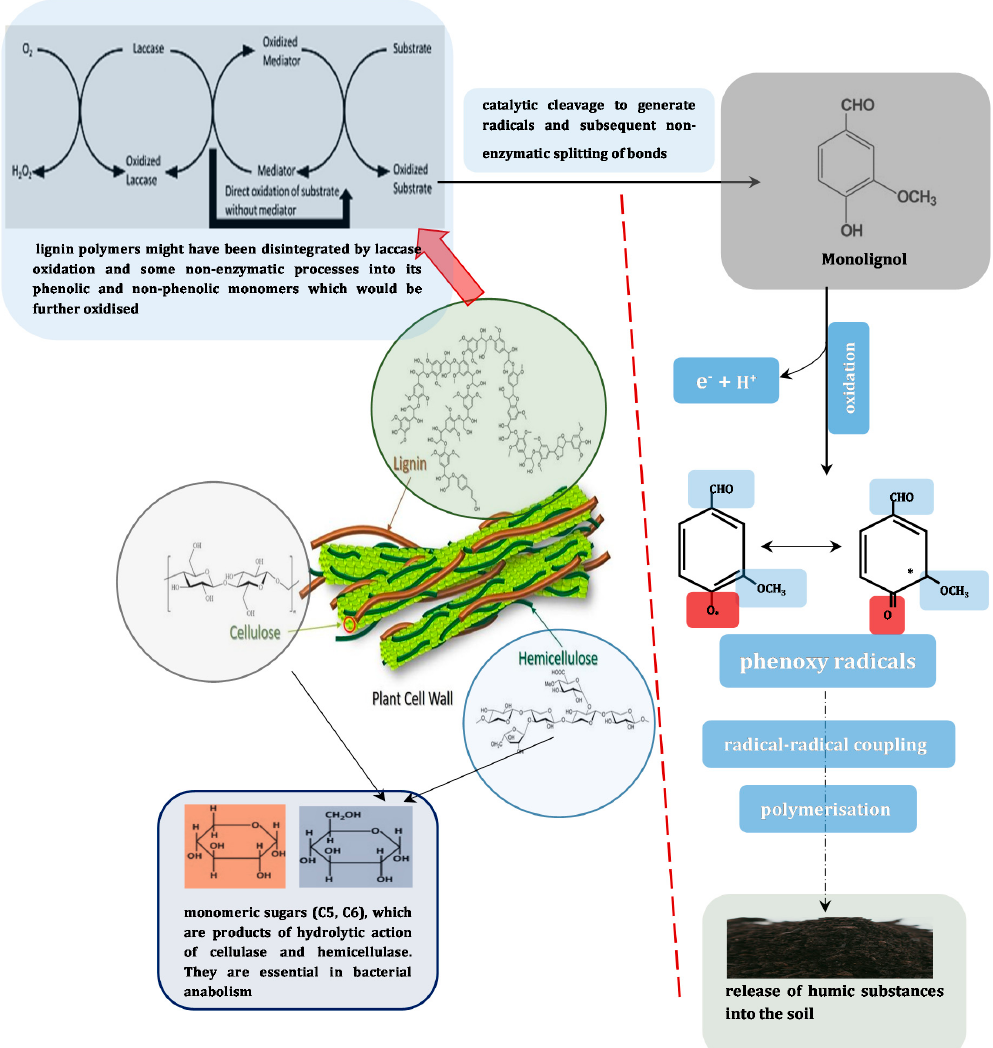
Figure 2. The characteristic disintegration of lignocellulosic polymers to liberate simpler carbon sources for bacterial metabolism and the consequent formation of humus from recalcitrant plant lignin residues and furfural. The left portion of the partition highlights the importance of hydrolytic enzymes in ensuring nutrient availability to the denizen bacteria, while the right portion summarises the mechanistic insight of humus formation.